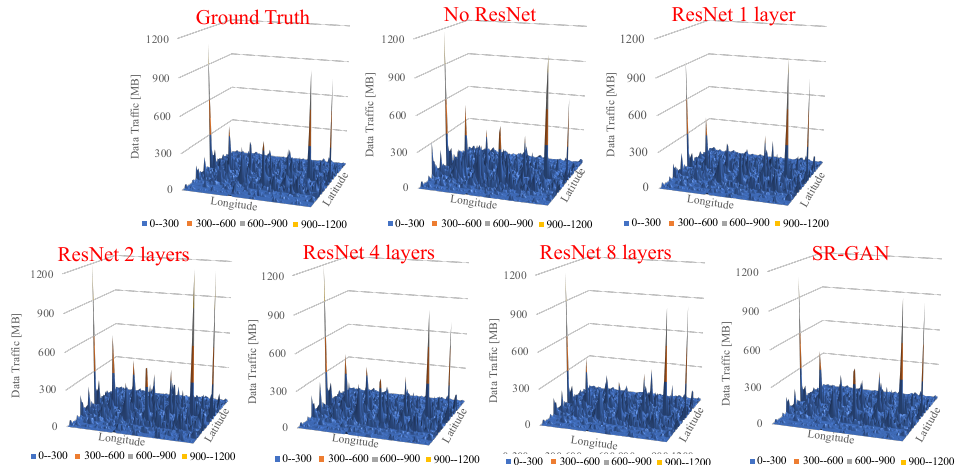
Figure 7. The snapshots of the output data of our proposed scheme with changes in ResNet size and SR-GAN (coarse-grained data as input), using data collected in Trentino on 1 December